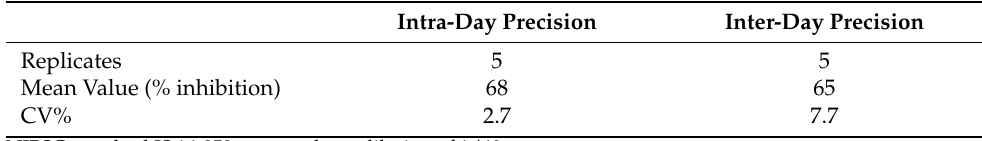
Table 1. Precision